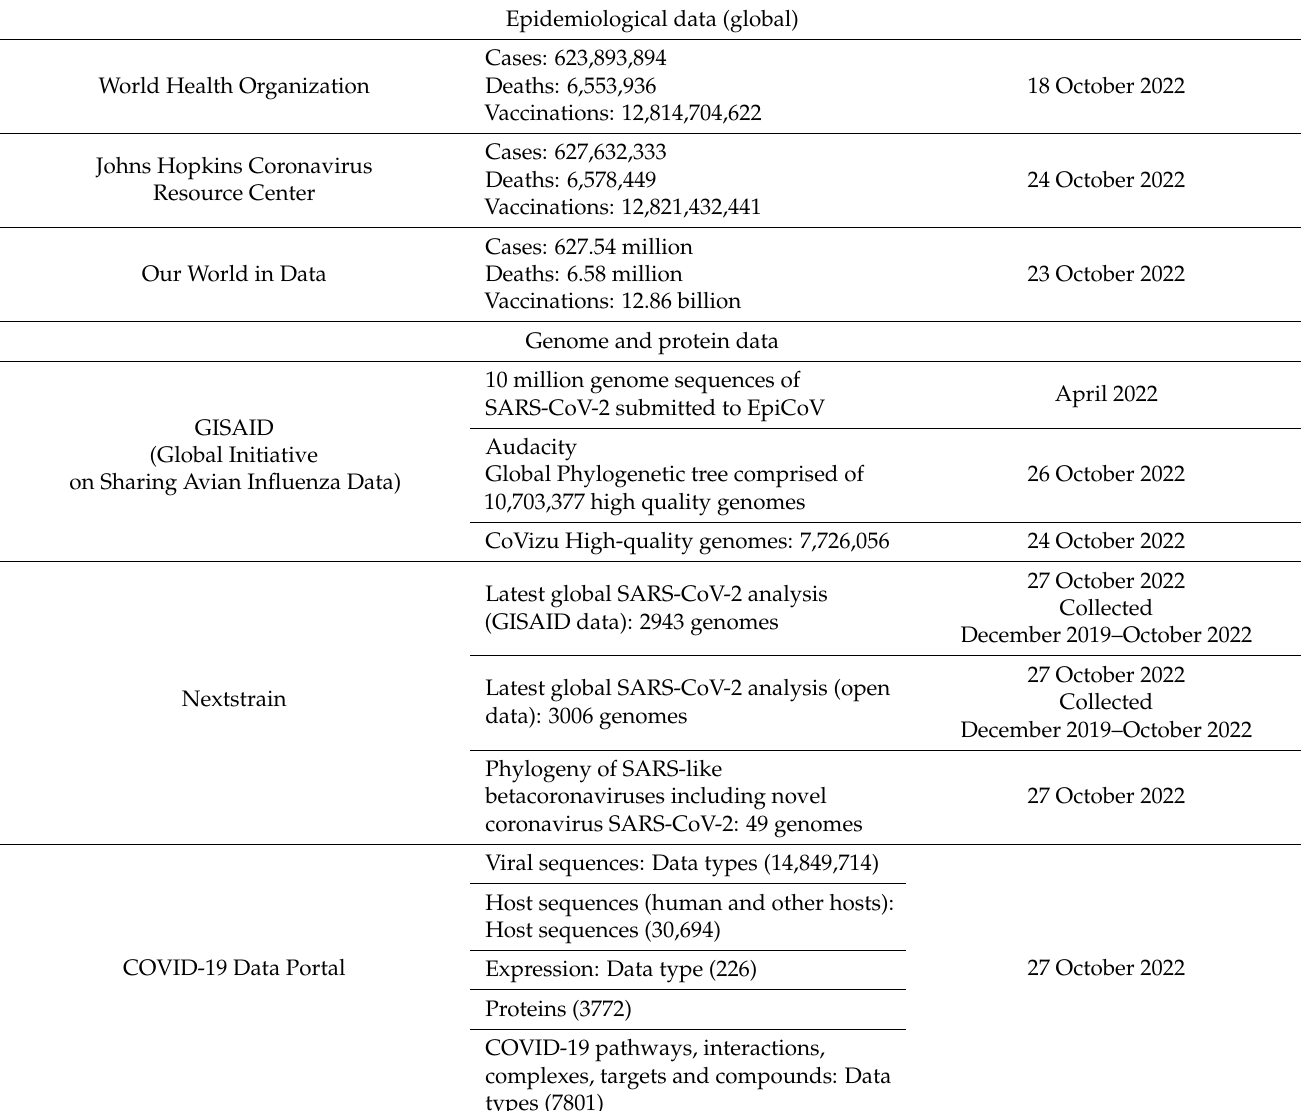
Table 1. Data volume categorized into genome and protein data, epidemiological data, and drug and target